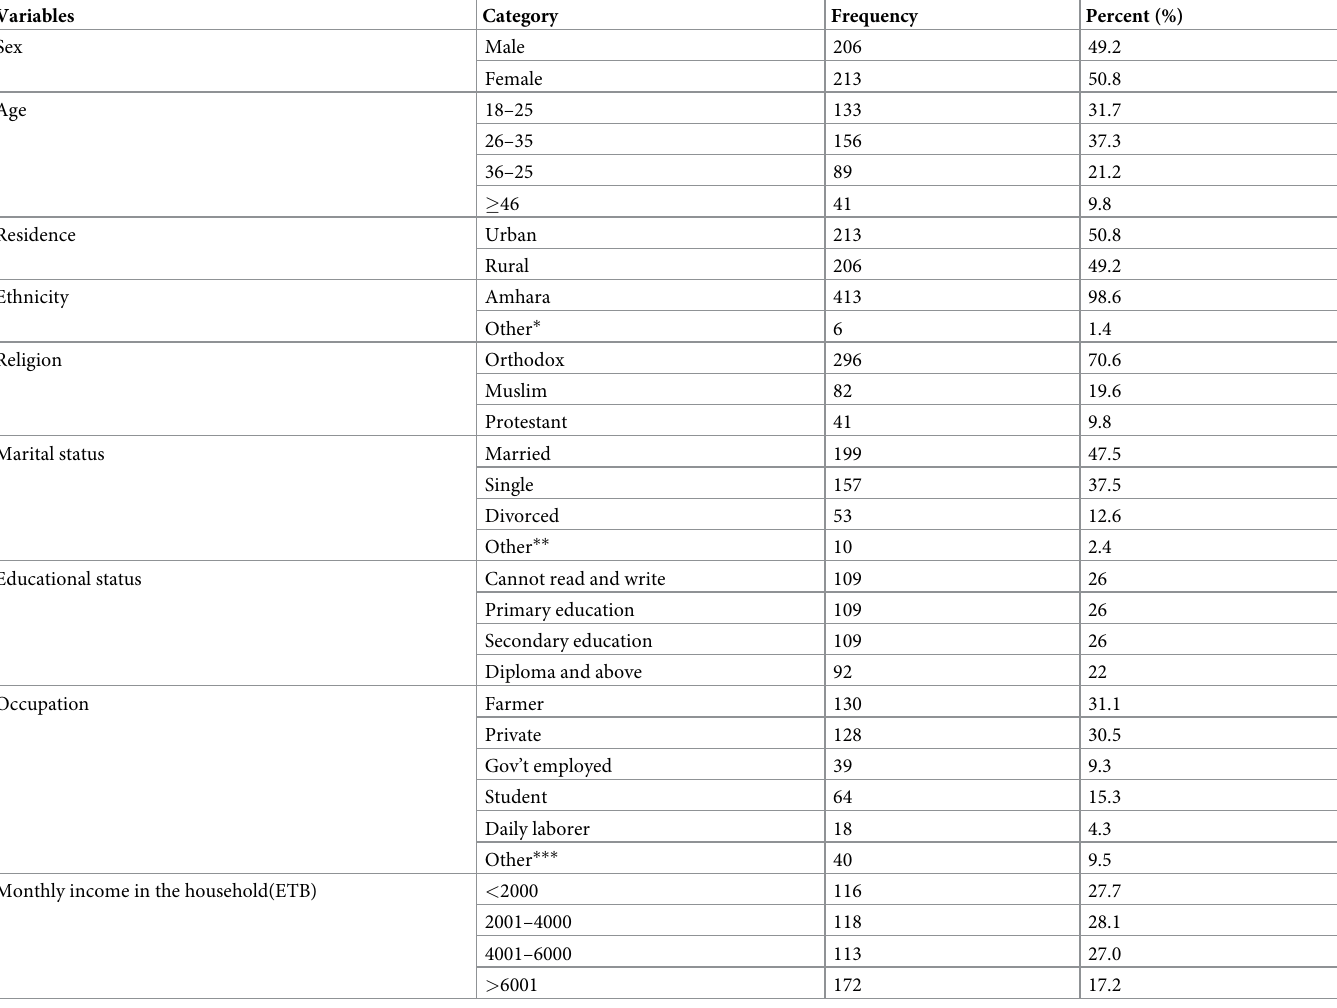
Table 1. Socio-demographic characteristics of respondent’s care among patients with mental illness at TGSH and FHCSH, North West, Ethiopia, 2022 (n =